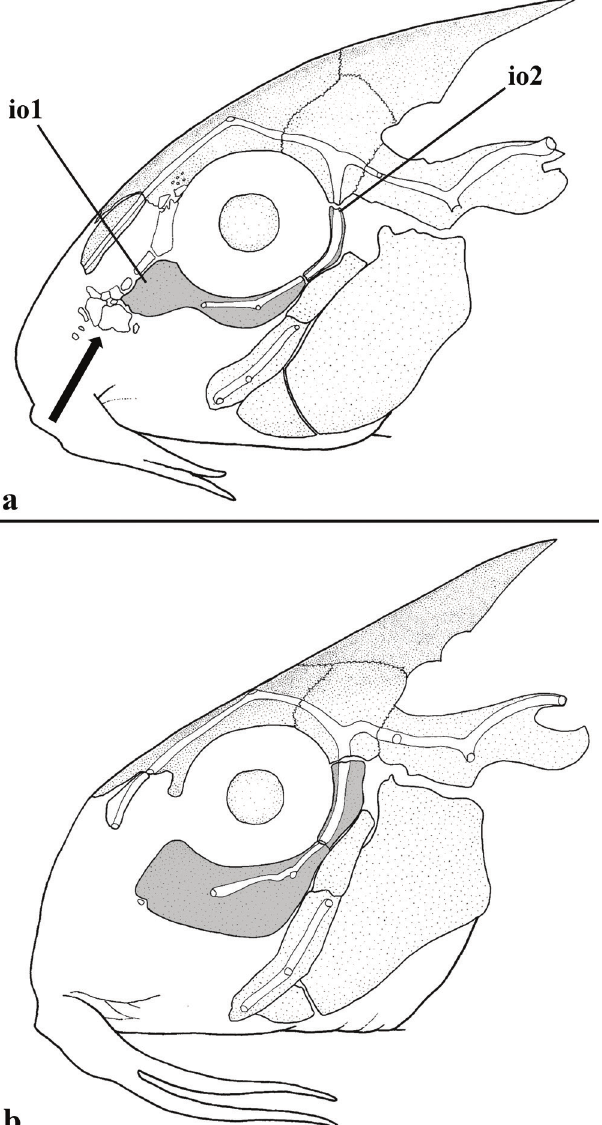
Fig. 2. Schematic drawing of the heads of (a) Corydoras gryphus , paratype, NUP 14676, 32.4 mm SL, and (b) Corydoras flaveolus , LBP 14596, 33.8 mm SL, in lateral view, showing the slender infraorbitals 1 and 2 of Corydoras gryphus and the thicker ones of C. flaveolus . Infraorbital 1 and 2 highlighted in gray. Arrow indicates the platelets present in lateral portion of snout and anterior margin of orbit, omitted in C. flaveolus